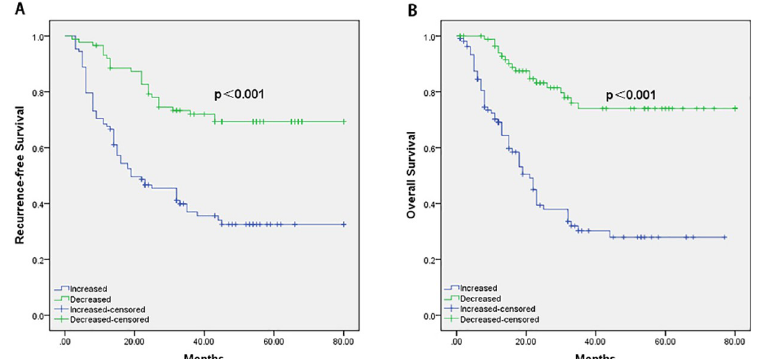
Fig 1. RFS and OS curves of patients. The increased postoperative PLR and decreased postoperative PLR of RFS(A) and OS(B).